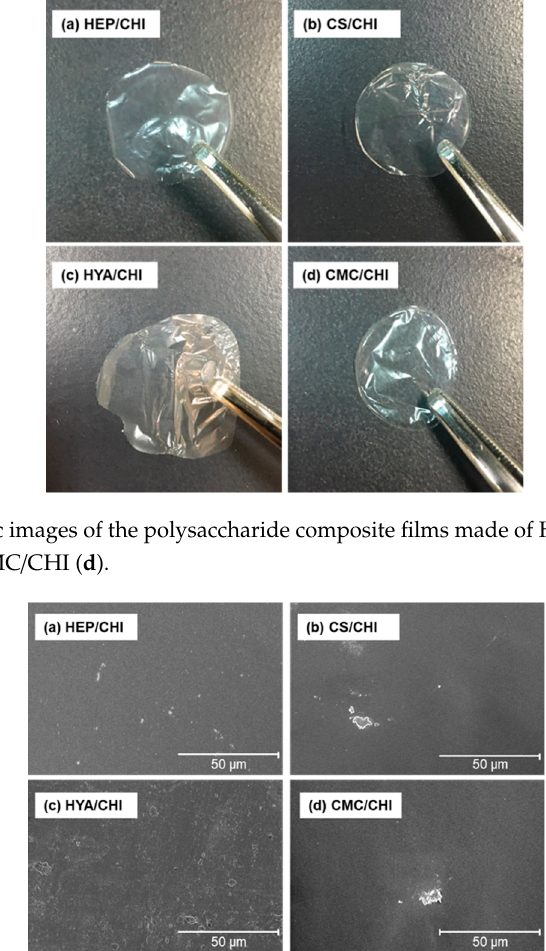
Figure 4. Cross-sectional SEM images of polysaccharide composite films composed of HEP/CHI ( a ), CS/CHI ( b ), HYA/CHI ( c ), and CMC/CHI ( d ). Table 2. Thickness of polysaccharide composite films.